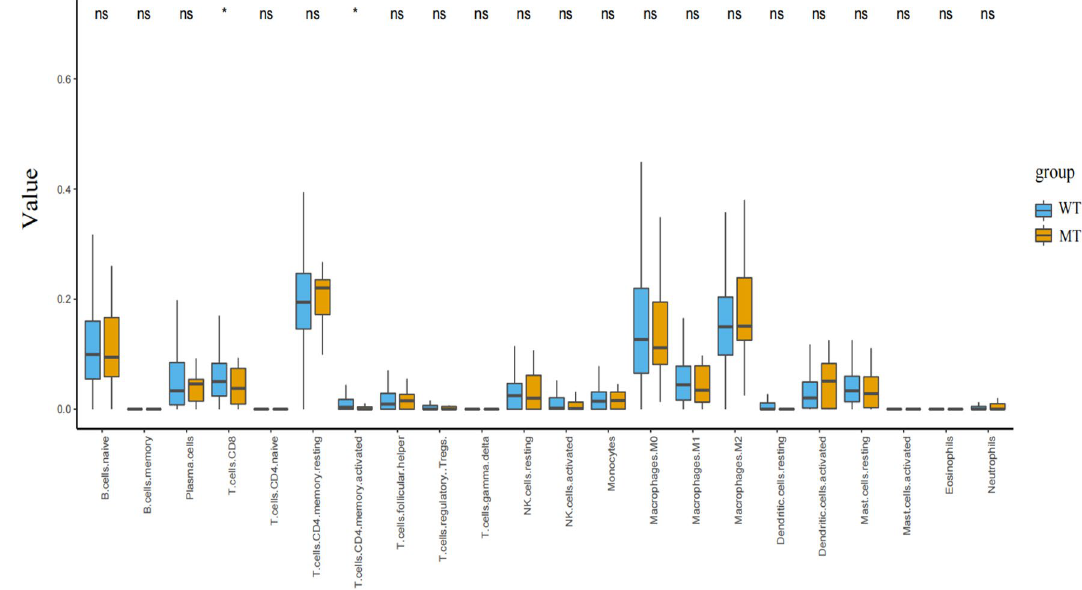
Figure 3. Compared the 22 types of immune cells in PBRM MT group and in WT group estimated by Cibersort algorithm.